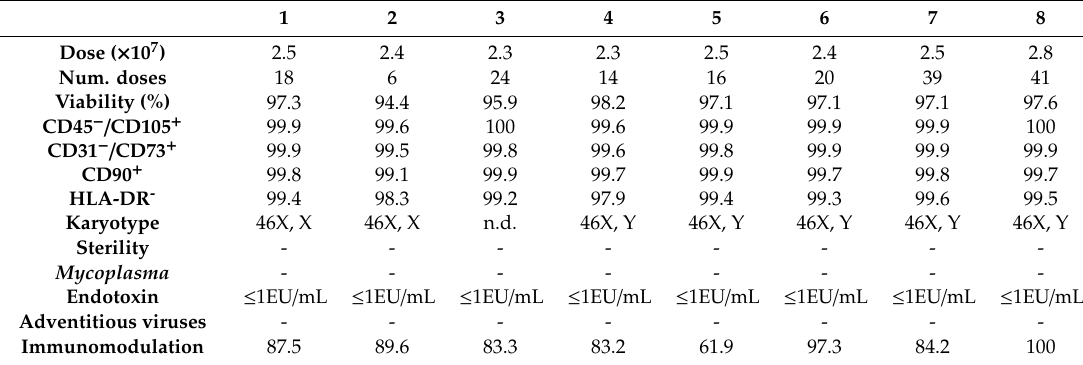
Figure 2. Immunophenotypic analyses of eight batches of clinical-grade WJ-MSC. The resulting values were always higher than 95%, in accordance with the established product specifications: 99.9 ± 0.2% CD45 − / CD105 + ( (cid:4) ), 99.8 ± 0.2% CD31 − / CD73 + ( (cid:78) ), 99.7 ± 0.3% CD90 + ( (cid:72) ), 99.1 ± 0.6% HLA-DR − ( (cid:7) ). Table 4. Critical quality attributes for each of the 8 batches of drug product.